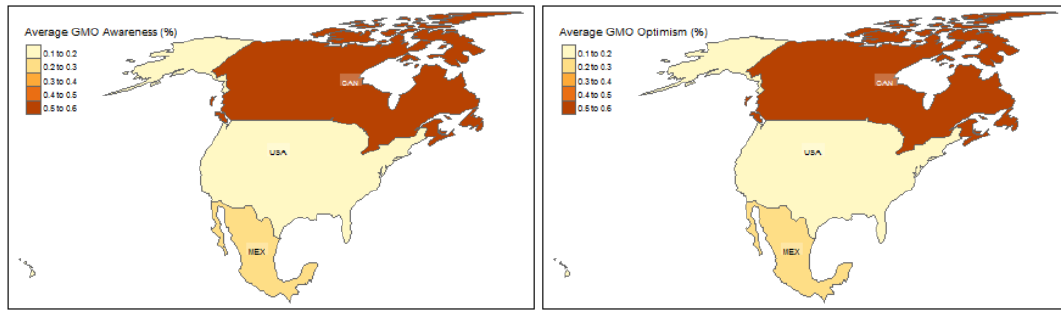
Figure 1. Spatial distribution of youth GMO awareness and expectations within NAFTA.